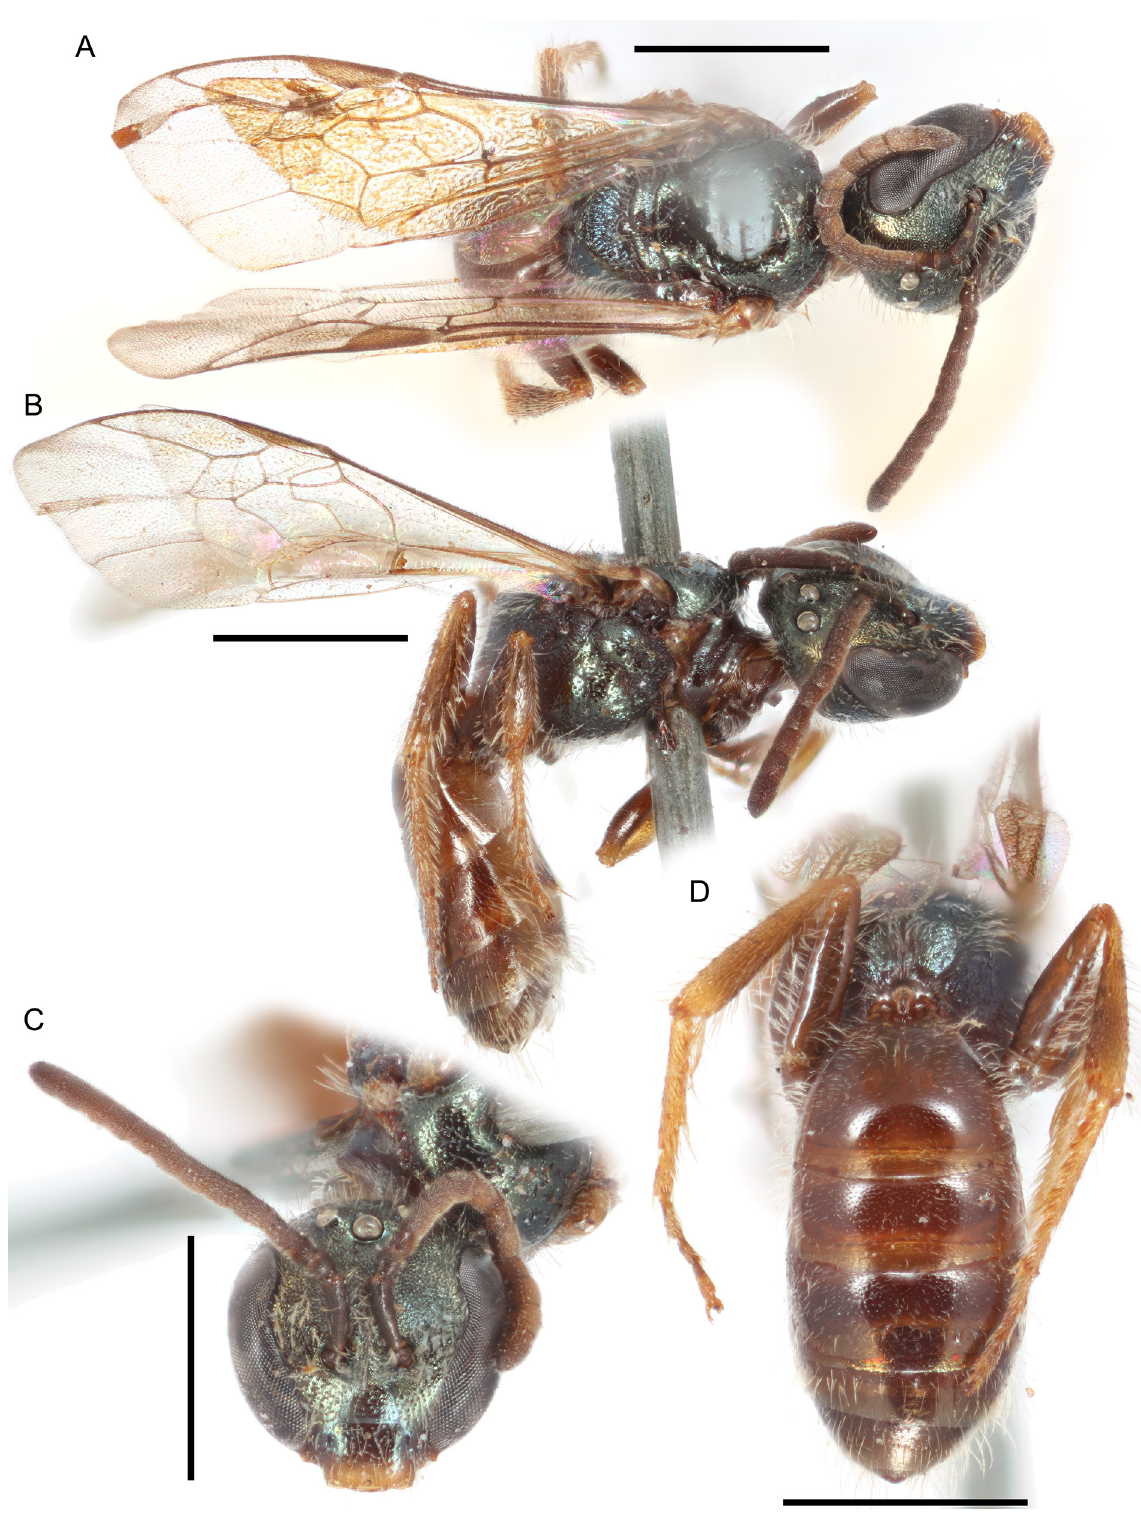
Fig. 32. Lasioglossum ( D. ) decorum sp. nov., ♂. A . Dorsal habitus. B . Lateral habitus. C . Face. D . Propodeum and metasoma. Scale bars: 1